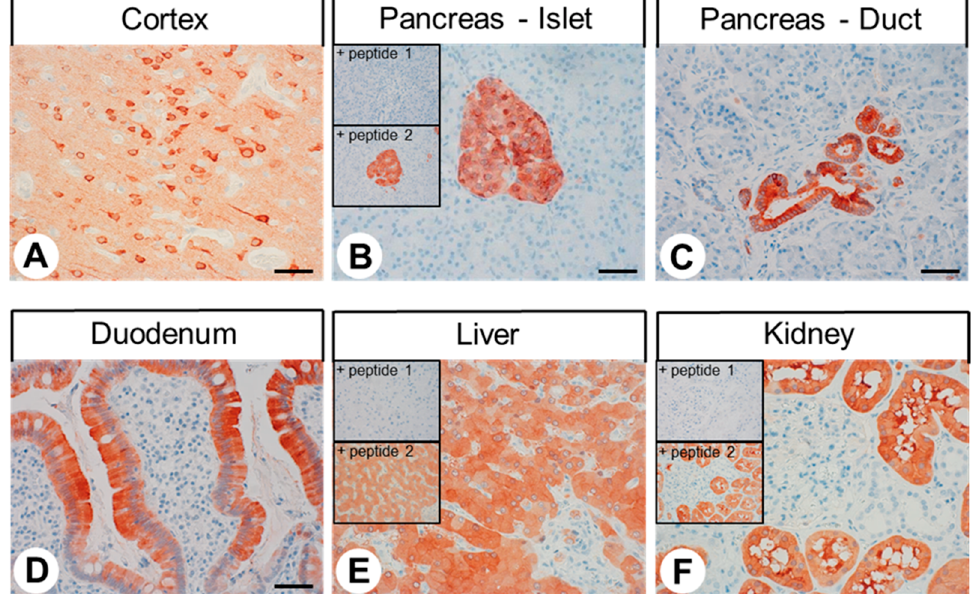
Figure 3. Immunohistochemical detection of GPER localisation in different normal human tissues. Immunohistochemical staining (red-brown colour) and counterstaining with haematoxylin. Scale bar: 100 µm ( A – F ). Insets in ( B , E , F ) represent adsorption controls, in which the anti-GPER